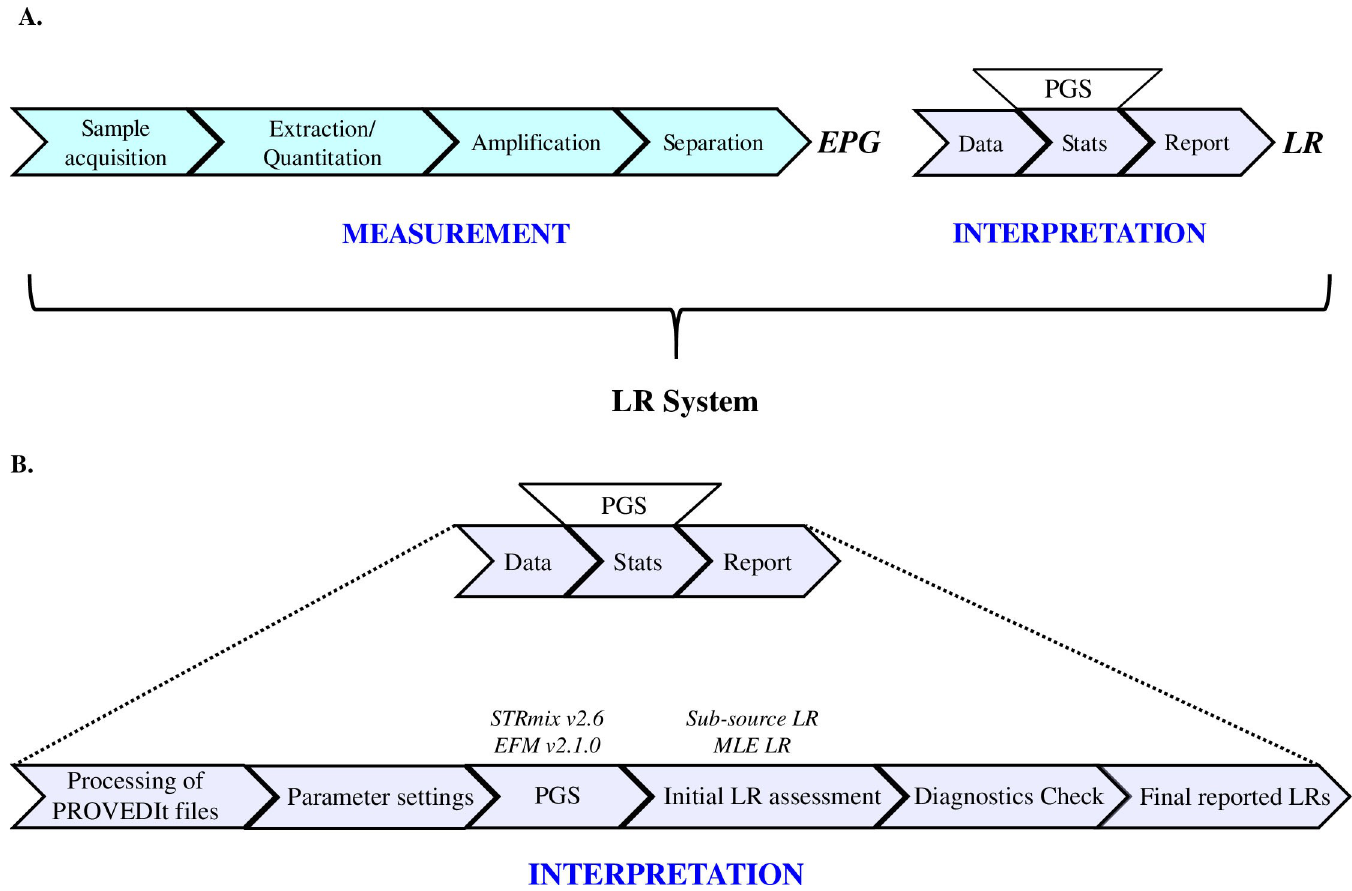
Fig 1. Schematic overview of the Likelihood Ratio (LR) system, adapted from [47,